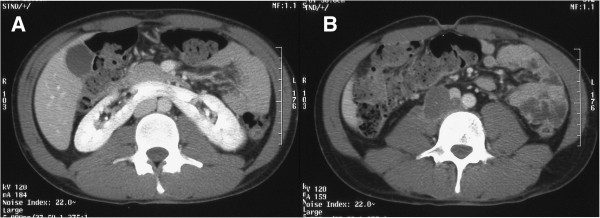
Retroperitoneal right laterocaval mass. CT shows the coexistence of a horseshoe kidney (A) and a retroperitoneal right laterocaval mass of the maximum diameter of 7 × 9 cm, indissociable from the iliopsoas muscle and without clear signs of infiltration of the caval wall (B).